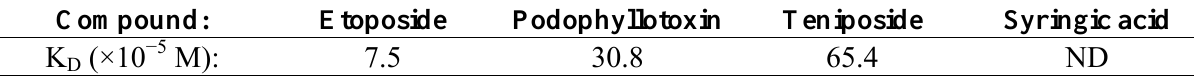
Table 2. Dissociation constants between GST-E2F-4 and each compound.